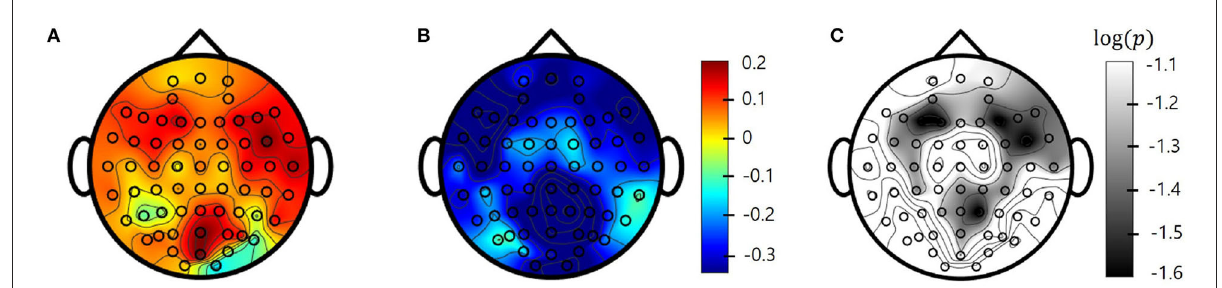
FIGURE2 Topographies of beta band averaged power spectral density (PSD) change (pre-post) rates in (A) responders and (B) non-responders. (C) log-scaled adjusted p -values (corrected) from false discovery rate (FDR) obtained from two-sample t -tests also in Beta band. Values between electrodes are interpolated.